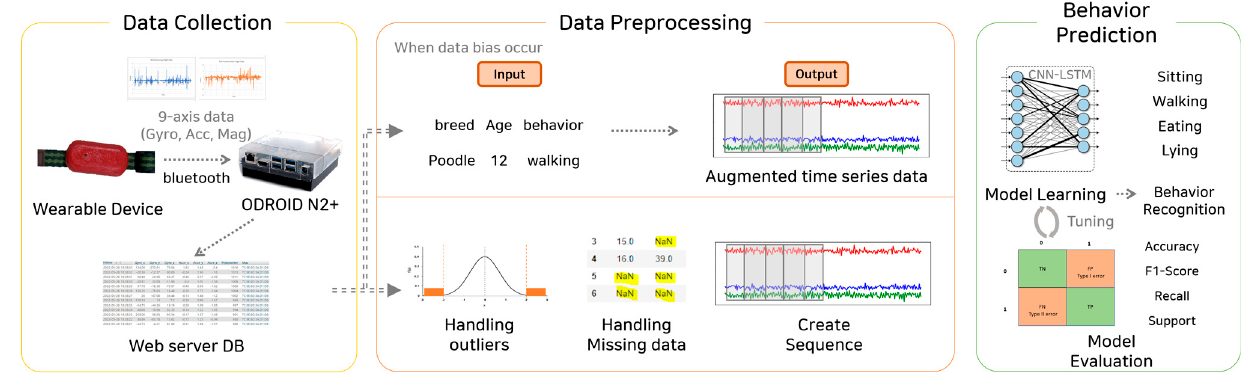
Figure 1. Behavioral prediction processes through multidimensional time − series augmentation. After collection, the nine‑axis sensor data (accelerometer, gyroscope, and geomag‑ netic sensors) and image data were stored in the data collection device using Bluetooth communication. Afterward, the saved data were transmitted to the web server database, in which sequences were used as input values for the learning models, and processed to detect outliers and missing values. When data biases occurred, time‑series sensor data were augmented using the data augmentation model for the text data, such as the breed, size, and behavior. Then, performance was verified using the trained deep learning CNN‑ LSTM model. Moreover, the actual labeled behavioral data and predicted values were compared using the performance verification